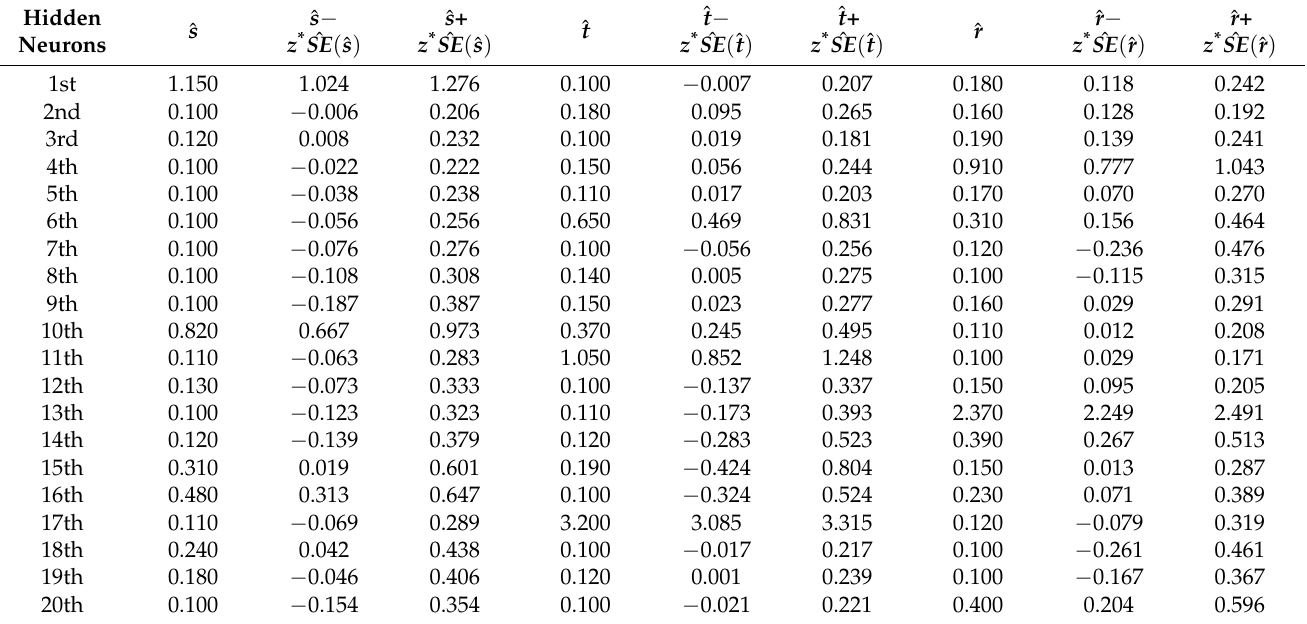
Table 3. Estimated weight parameters and associated confidence